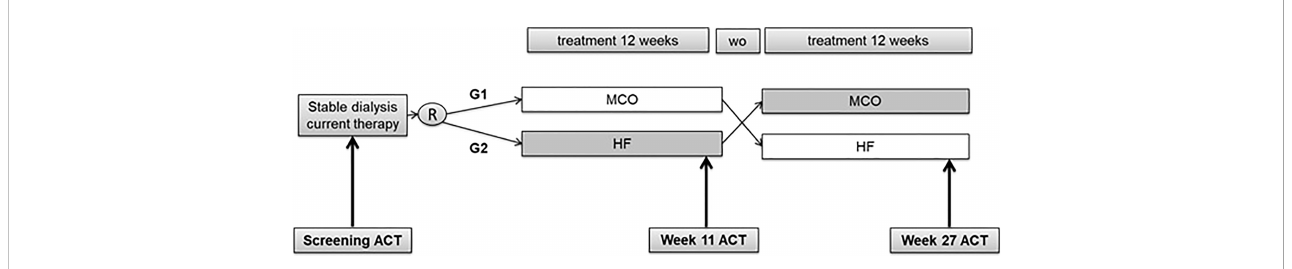
FIGURE 1 Study design. ACT, Activated Clotting Time; R, Randomization; WO, washout; MCO, medium cut-off membrane; HF, High Flux membrane; G1, Group 1 (MCO followed by HF); G2, Group 2 (HF followed by